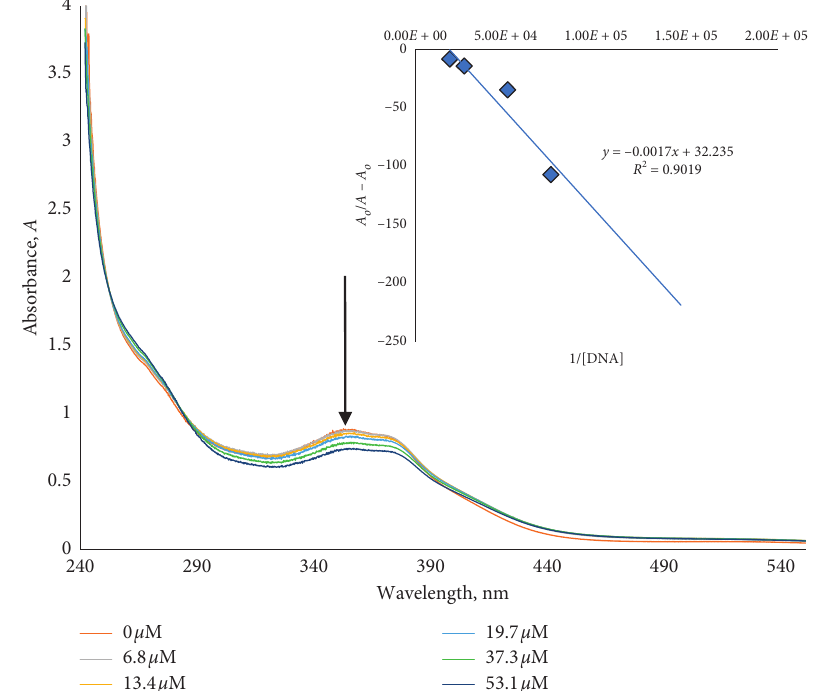
Figure 13: UV-visible absorption spectra for the C4 at 18 µ M without CT-DNA and with serial addition of DNA. Inset is the Bene- si–Hildebrand plots for the determination of binding constant.